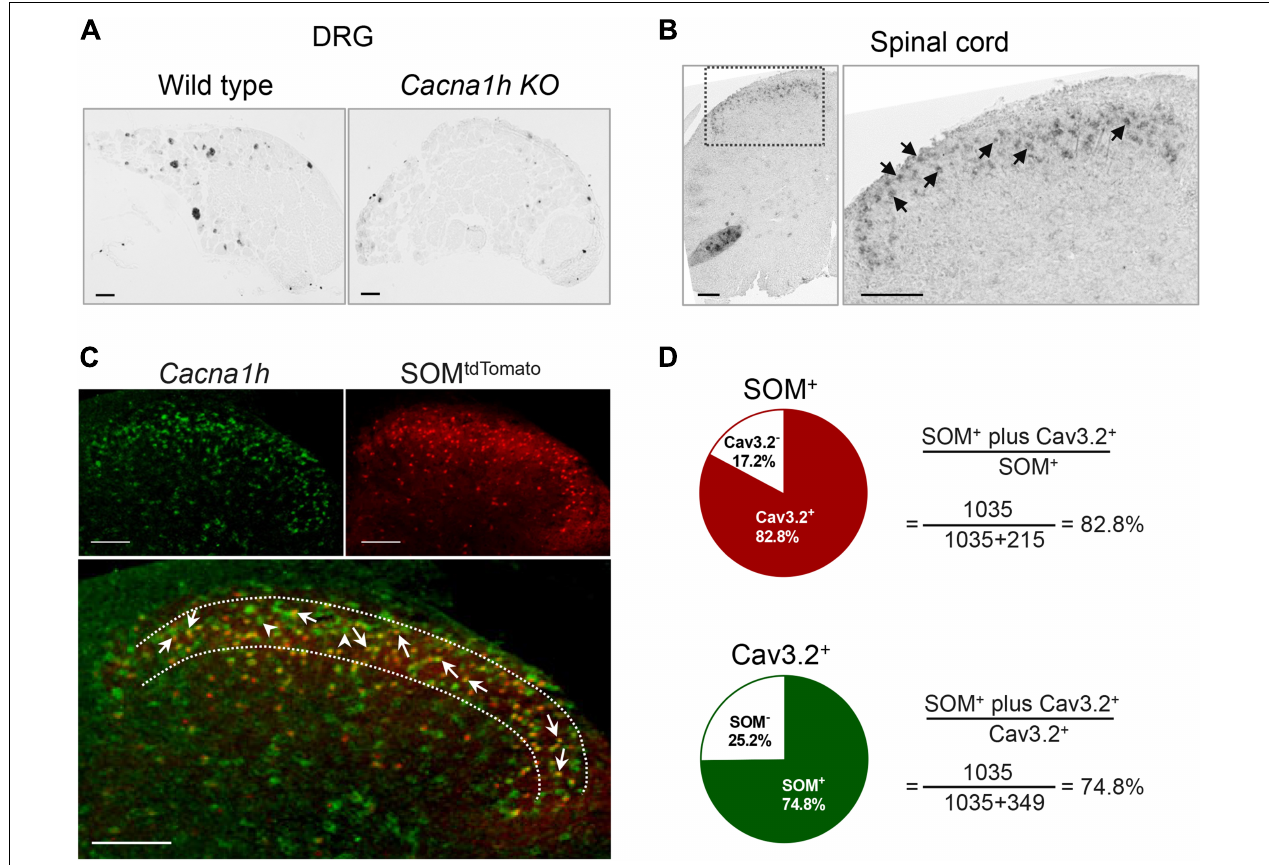
FIGURE 1 | In situ hybridization staining of Cacna1h in DRG and spinal dorsal horn. (A) In situ hybridization staining of Cacna1h in the DRG of wild type (WT, left) and Cacna1h knockout (KO, right) mice. (B) In situ hybridization staining of Cacna1h in the lumbar segment of the spinal cord in mice. Arrows indicate Cacna1h + cells. (C) In situ hybridization staining of Cacna1h (left) and SOM tdTomato neurons (right) in the spinal dorsal horn. Superimposition of the images is shown below. Arrows indicate Cacna1h and SOM tdTomato double-positive cells, and arrowheads indicate Cacna1h -positive cells. (D) Quantification analysis of the proportion of double-positive cells in SOM + (top) and Cav3.2 + (below) cells. Sixteen hemisections of the spinal cord from 4 male mice in each group were quantified. Scale bar, 100 µ